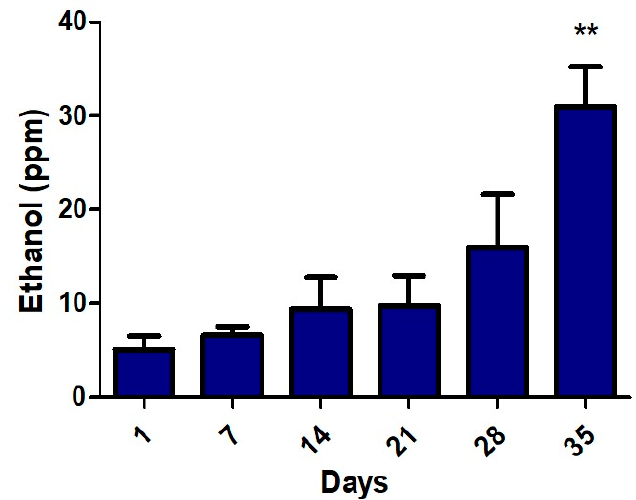
Figure 5. Ethanol concentrations emitted from “Golden Delicious” apples over 35 days under normal conditions. ** p < 0.01 for unpaired t- test with Welch’s correction.